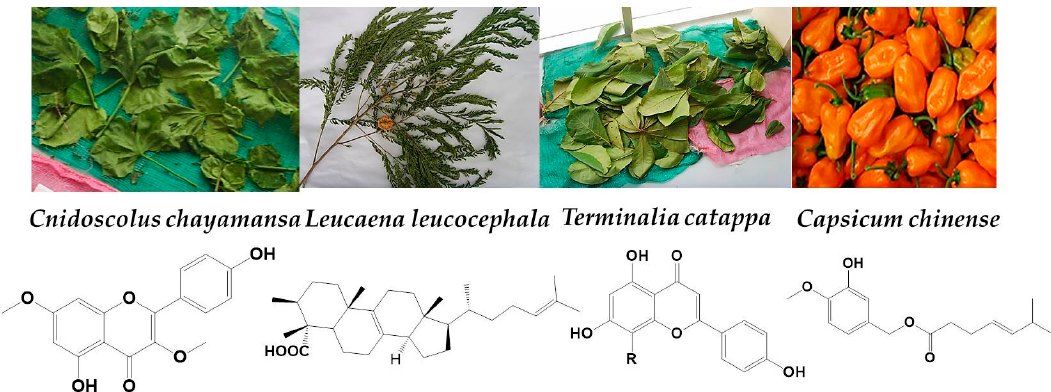
Figure 1. Pictures of plants assayed in this study and derived compounds previously reported in